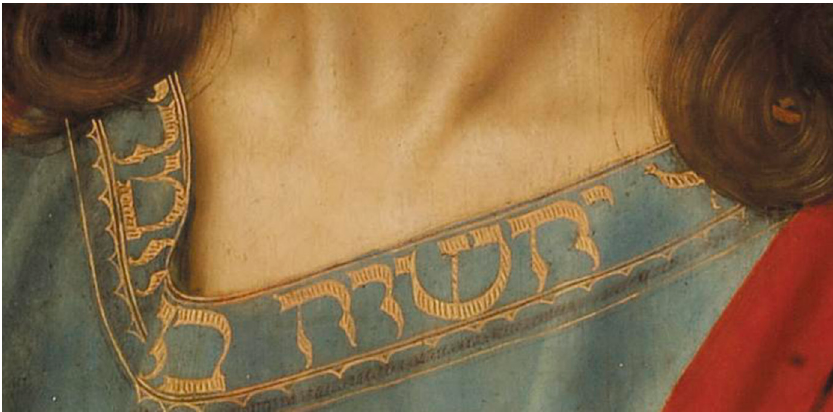
Figure 6. Quentin Massys. Christ (detail), before 1529. Private collection [Sotheby’s (New York) 24 January 2008, lot 6]. Courtesy of